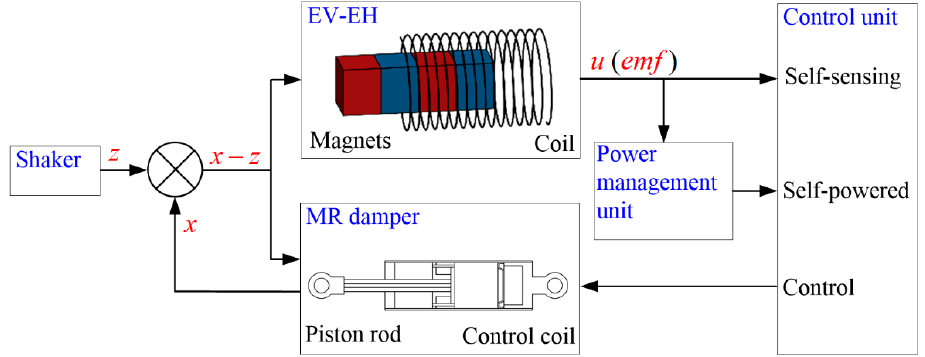
12 of 18 Figure 14. Active power 𝑃 (cid:3028) vs. relative velocity amplitude 𝐴 (cid:3049)(cid:3045) . Figure 15. Active power 𝑃 (cid:3028) vs. frequency 𝑓 (cid:3053) . 5. Self-Sensing and Self-Powered Action for Magnetorheological Damper Control